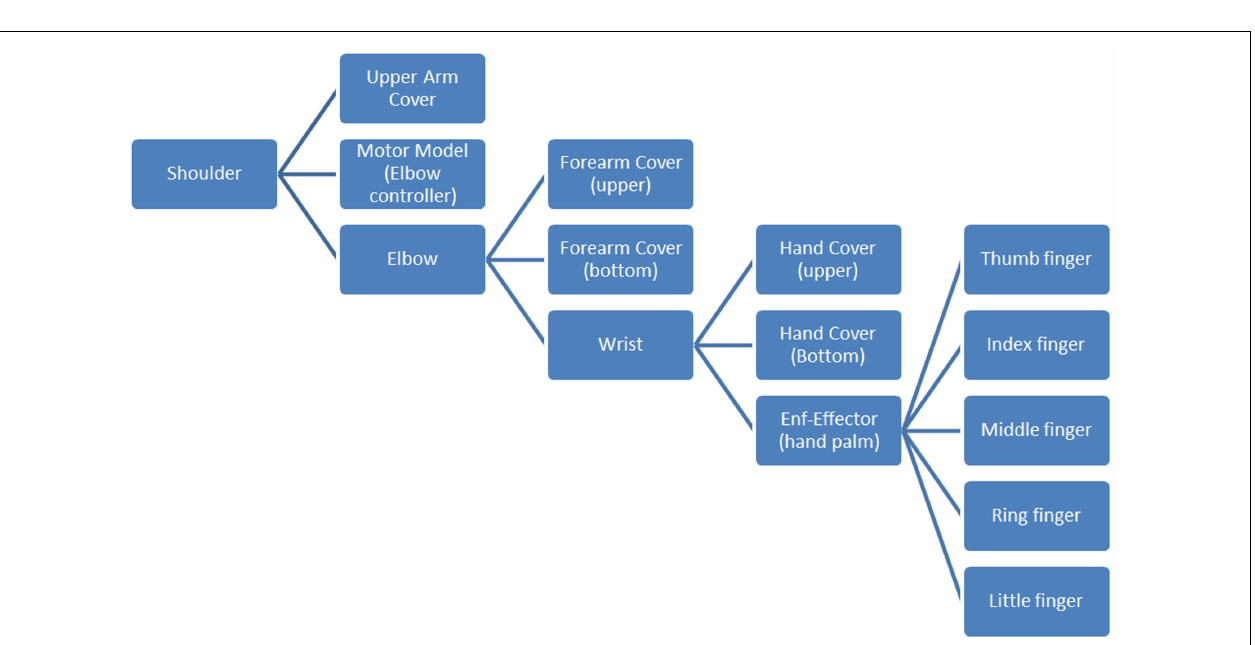
FIGURE 11 | Hierarchical tree with the most important Unity Objects from the shoulder to the fingers .